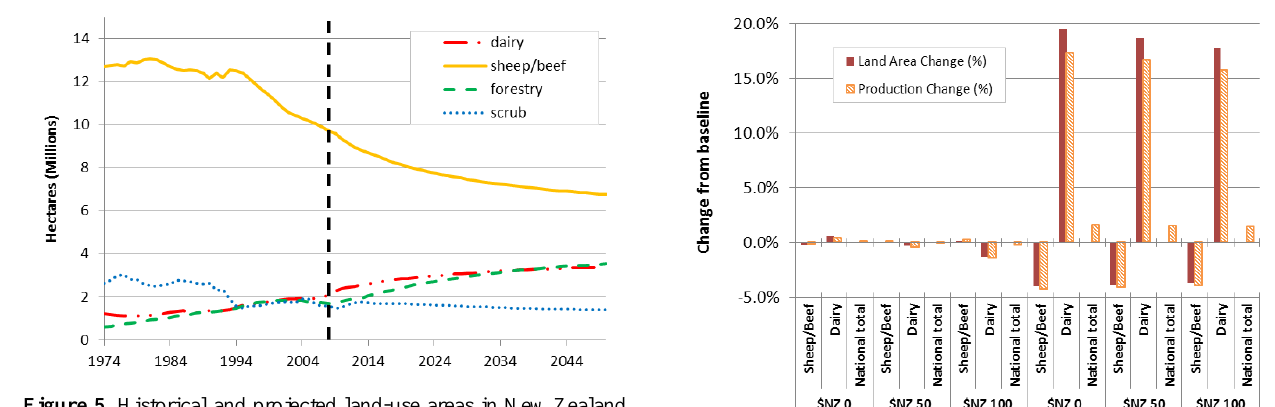
Figure 5. Historical and projected land-use areas in New Zealand (carbon price = NZD0). Data to the left of the dashed line (2008) are historical, and to the right are estimated by LURNZ based on exogenous forecasts of economic variables.